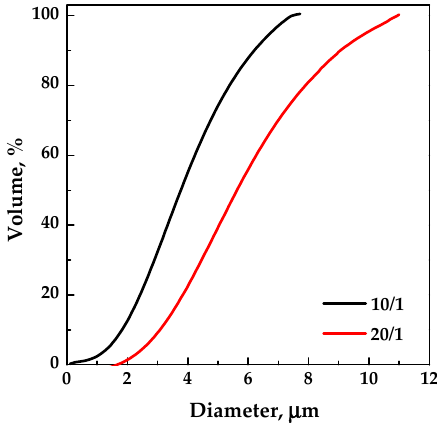
Figure 10. Volumetric cumulative PSDs of EUD/THEOP particles precipitated from DMSO at 40 °C, 12 MPa and 40 mg/mL; effect of the polymer/drug ratio.